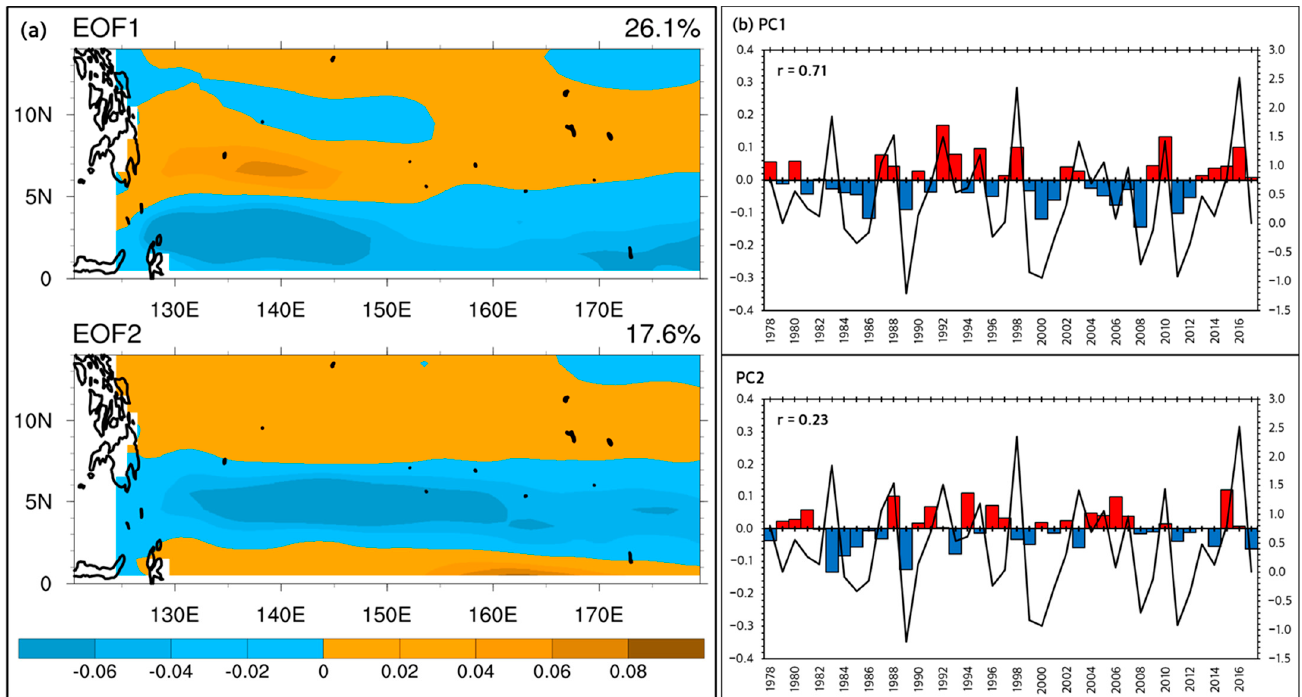
Figure 7. The first and second EOF modes of boreal winter (DJF) zonal current geographical distri- bution ( a ), and associated time series PC from 1978 to 2017 overlaid with the NIÑO 3.4 indices (black line) ( b ). In ( b ), the positive and negative values denote the greater and weaker NECC magnitudes, respectively.